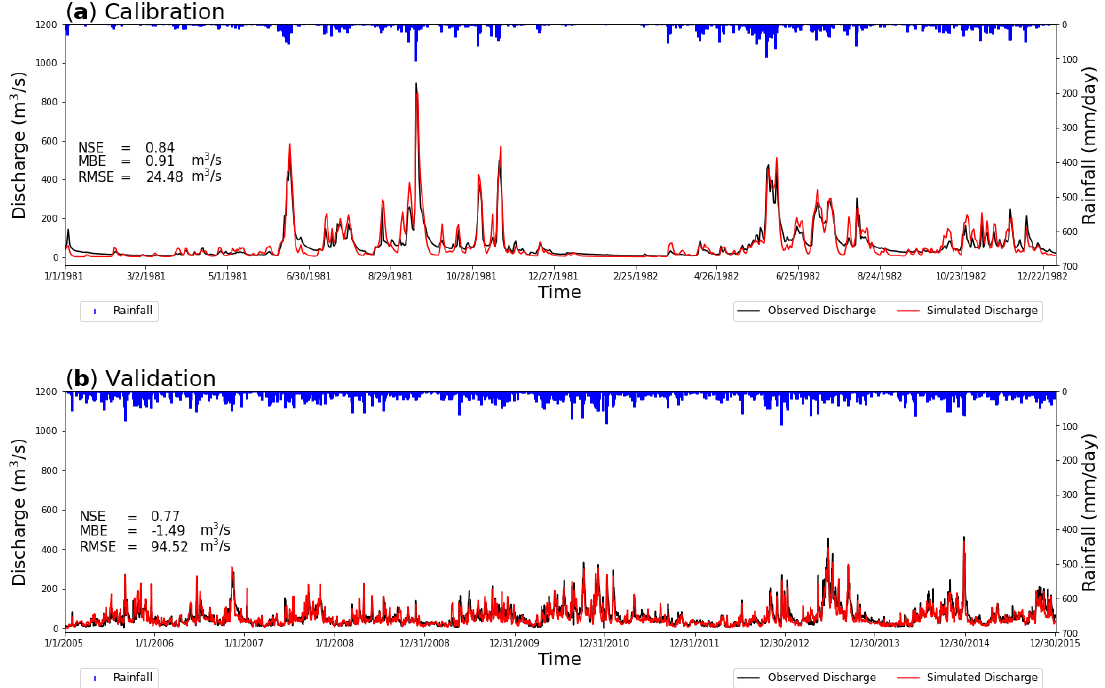
Figure 9. Comparison between observed discharge and simulated discharge: ( a ) model calibration for 1981–1982 under the natural river flow; and ( b ) model validation for 2005 to 2015 with dam operations. Table 3. Model-calibrated parameters for the MRB.